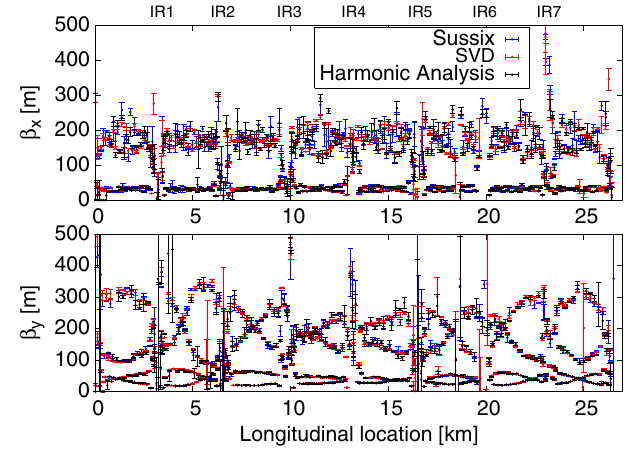
FIG. 1. (Color) The measurement of the horizontal (top) and vertical (bottom) (cid:2) functions for the LHC beam 2. The three different algorithms show consistent results. The locations of the LHC interaction regions (IRs) are marked on the top. spond to vertical and horizontal rms phase errors of 0.8 and 1.6 degrees, respectively. The vertical error is already below the 1 (cid:3) resolution, which is the target of the LHC optics measurements. At 1 (cid:3) resolution Monte Carlo simu- lations of LHC optics corrections show a few percent probability of failure to achieve optics specifications [4].